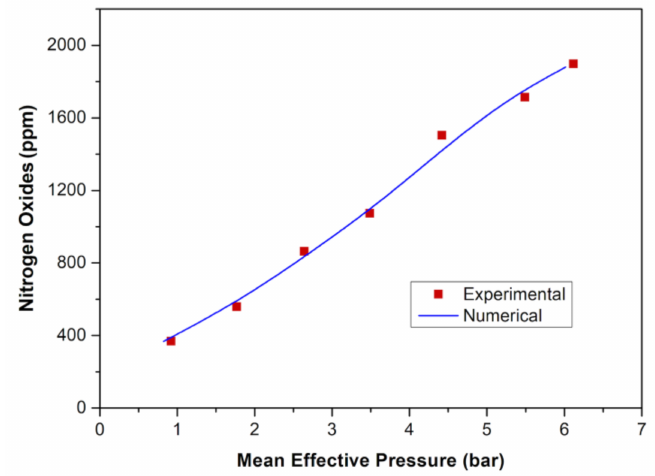
Figure 5. Comparison between numerical and experimental results in terms of NO x